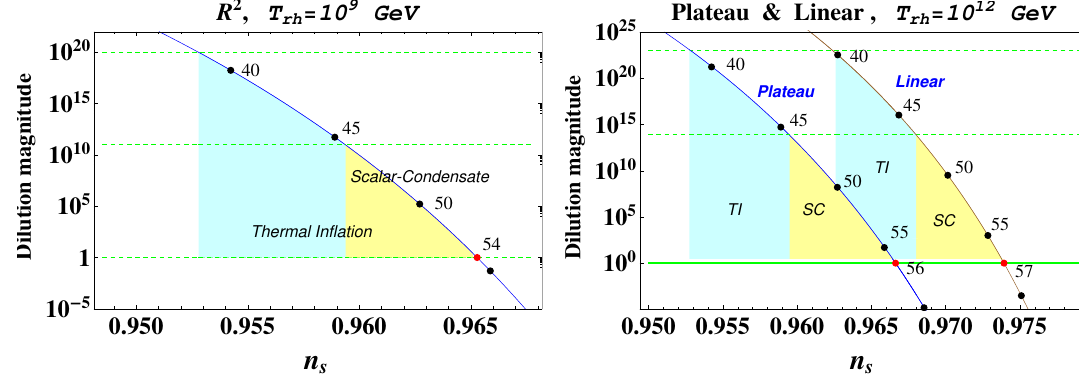
Figure 1 . The shift in the spectral index value and the dilution magnitude D X due to scalar condensate domination (SC) and due to thermal in(cid:13)ation (TI) for the Starobinsky R 2 in(cid:13)ation (left panel), general plateau and linear in(cid:13)ationary potentials (right panel). The maximum number of the dilution is given by the ratio T rh =T BBN for scalar condensate domination and the (cid:1) N X j constraint for thermal in(cid:13)ation. The red dots show the e-folds number if there is no entropy production after infaton decay. It is N (th) ’ 54 for R 2 in(cid:13)ation and N (th) ’ 56 ; 57 for the general plateau and linear potential respectively (red dots). Order O (1) corrections to the dilution magnitude are expected due to the uncertainty at the number of the relativistic degrees of freedom at ultra high